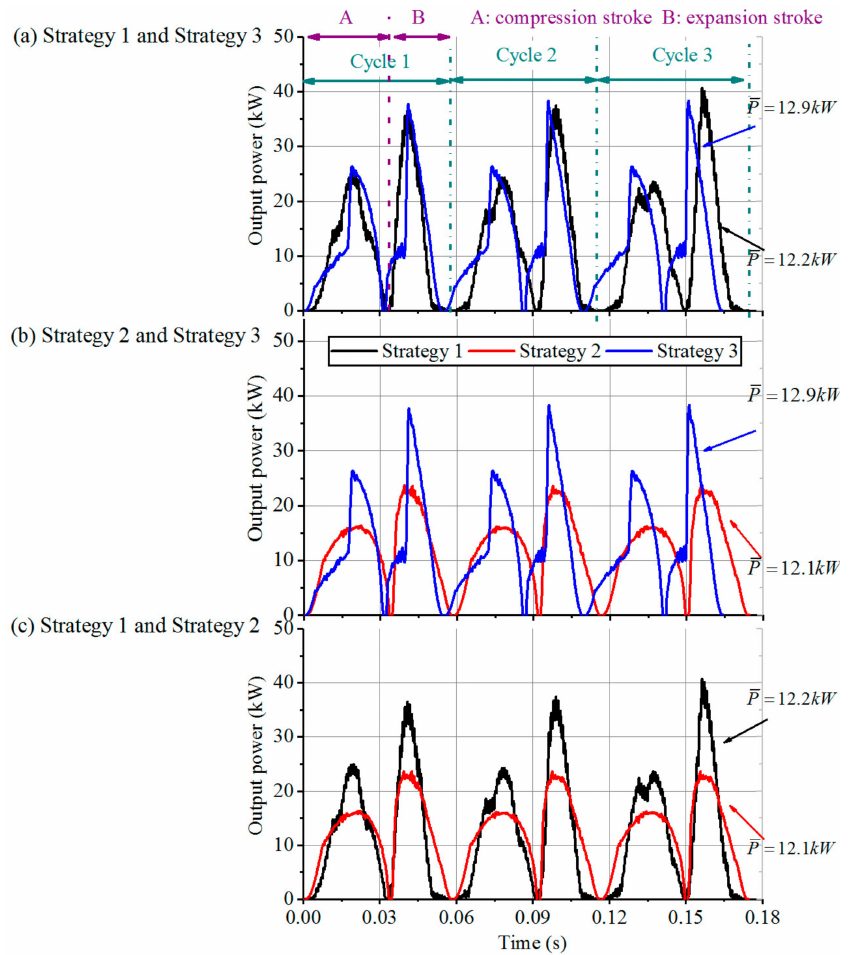
Figure 20. Instantaneous power